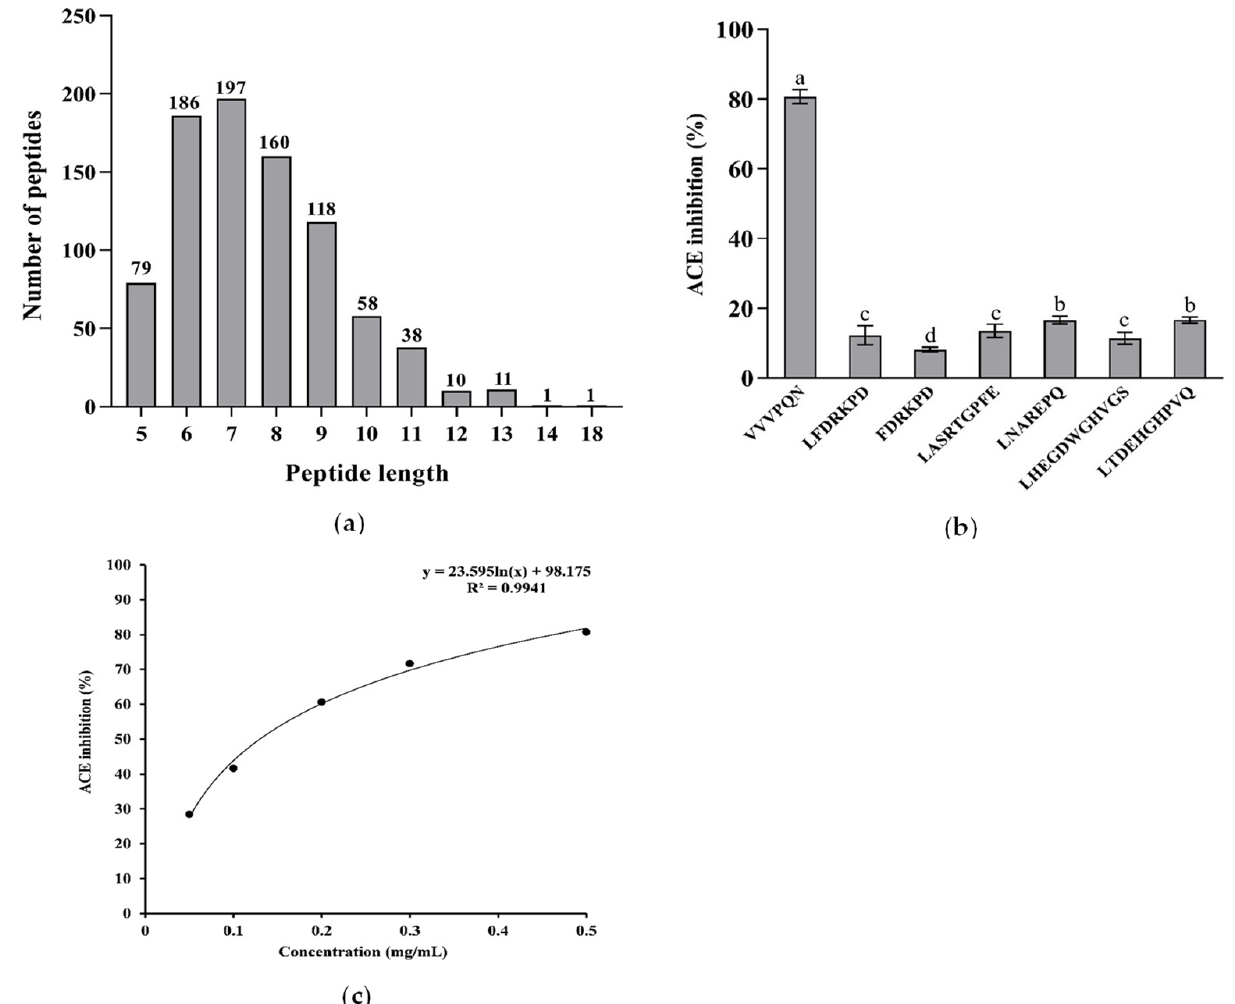
Figure 4. ( a ) The number of peptides with varying lengths identified from the F2 component. ( b ) The selected peptides’ ACE inhibitory activity. ( c ) The ACE inhibitory activity and the regression analysis of VVVPQN. The results are presented as the means ± SD (n = 3). Different letters indicate significant differences at p < 0.05. Table 1. Binding energy and physicochemical characteristics of the selected